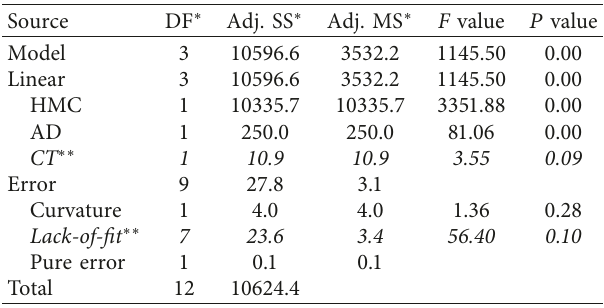
Table 4: Analysis of Variance (ANOVA) for transformed response. Source DF ∗ Adj. SS ∗ Adj. MS